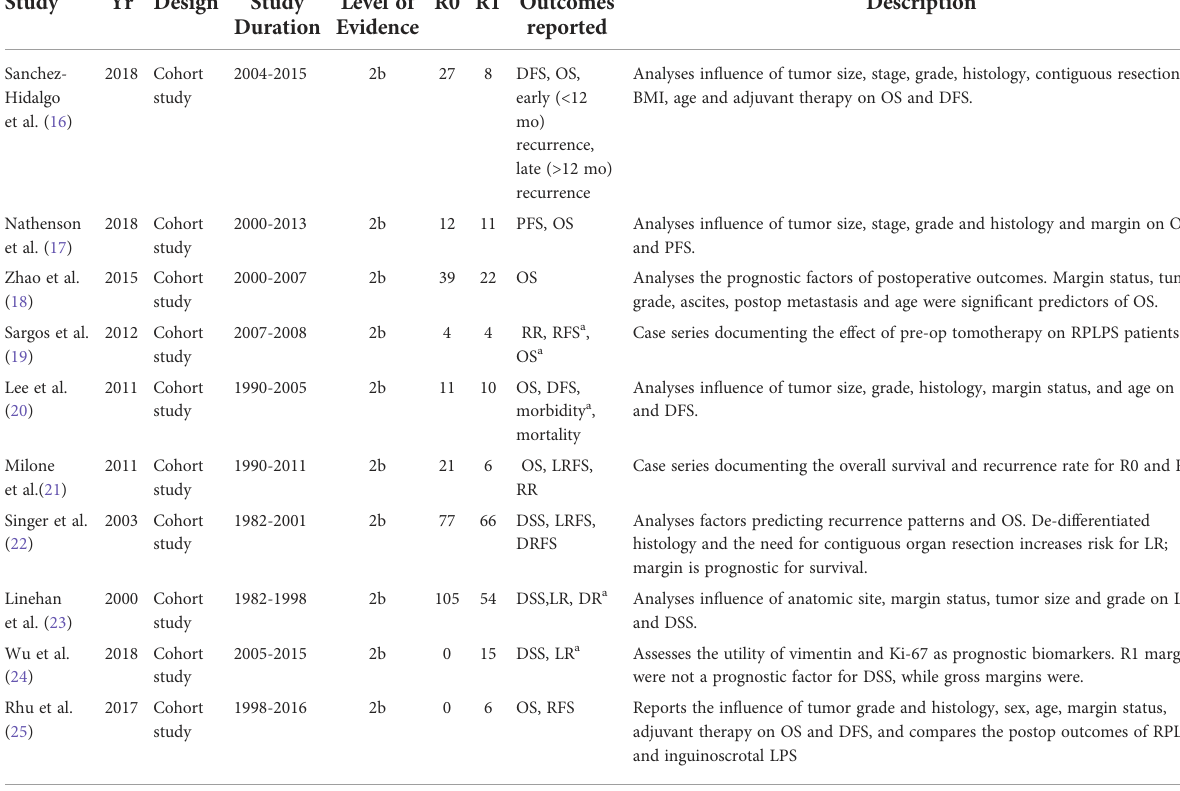
TABLE 1A List of cohort studies reporting on retroperitoneal liposarcomas.